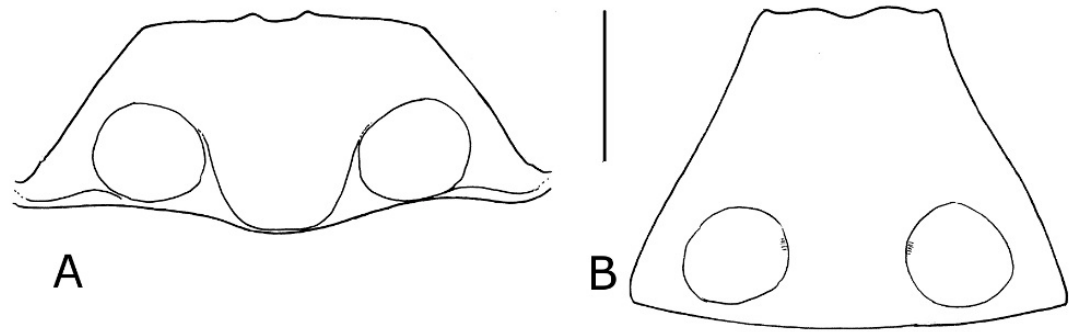
Figure 21. Sclerocardius indicus Hartmann, tergite VII, dorsal: ( A ) male, and ( B ) female. Scale bar = 1 mm.